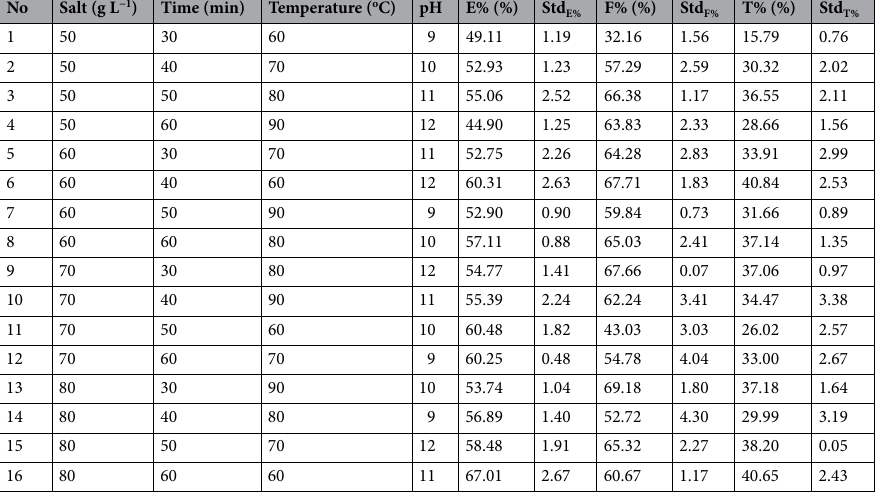
Table 4. E%, F%, and T% values of O5-dyed samples in the L16 (4^4) orthogonal experimental scheme.